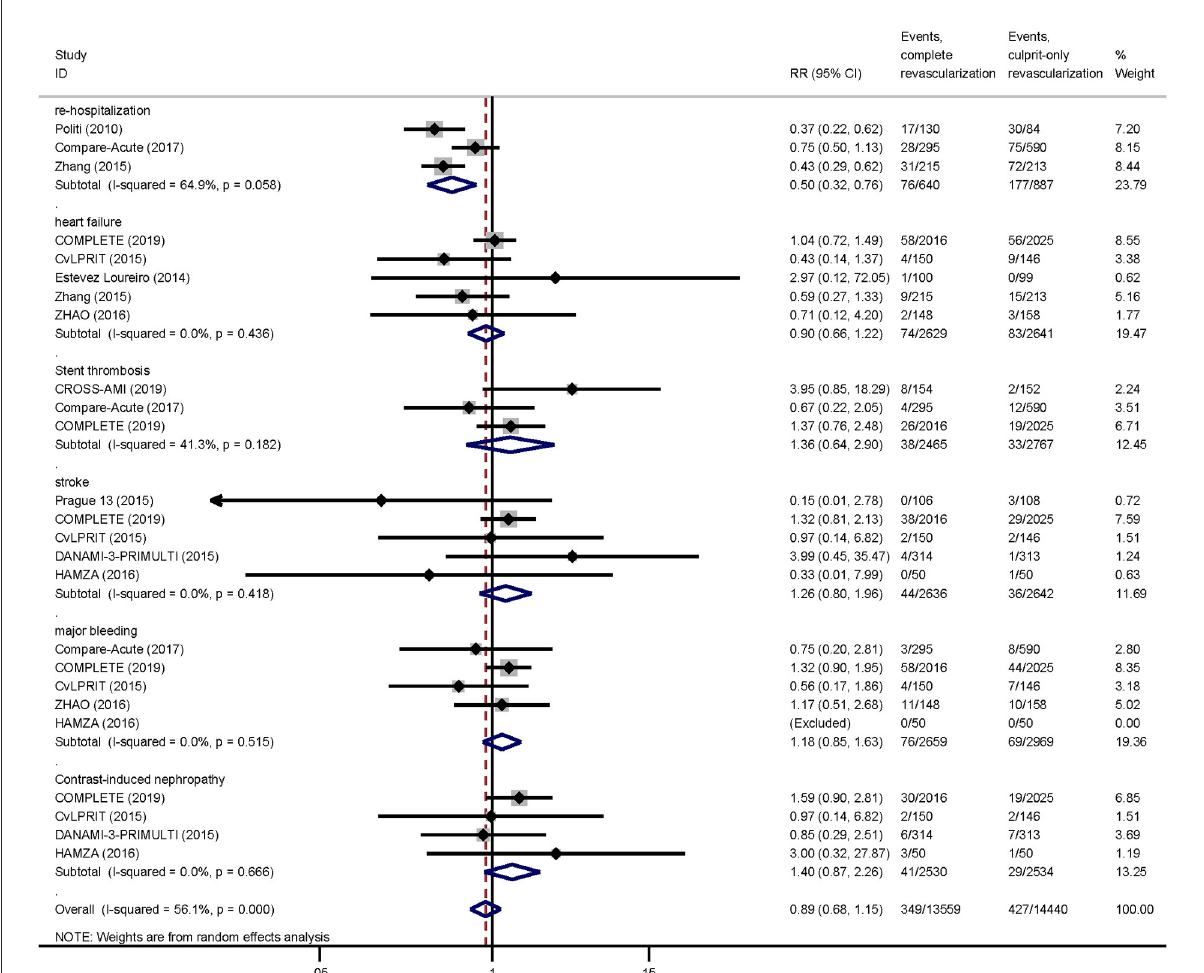
FIGURE4 Pairwise meta-analysis other outcomes. Summary forest plot for re-hospitalization, heart failure, stent thrombosis, stroke, major bleeding, contrast-induced nephropathy. CI, confidence interval; MACE, major adverse cardiac event(s); RR, risk ratio; MI, myocardial infarction; Other abbreviations as in Table